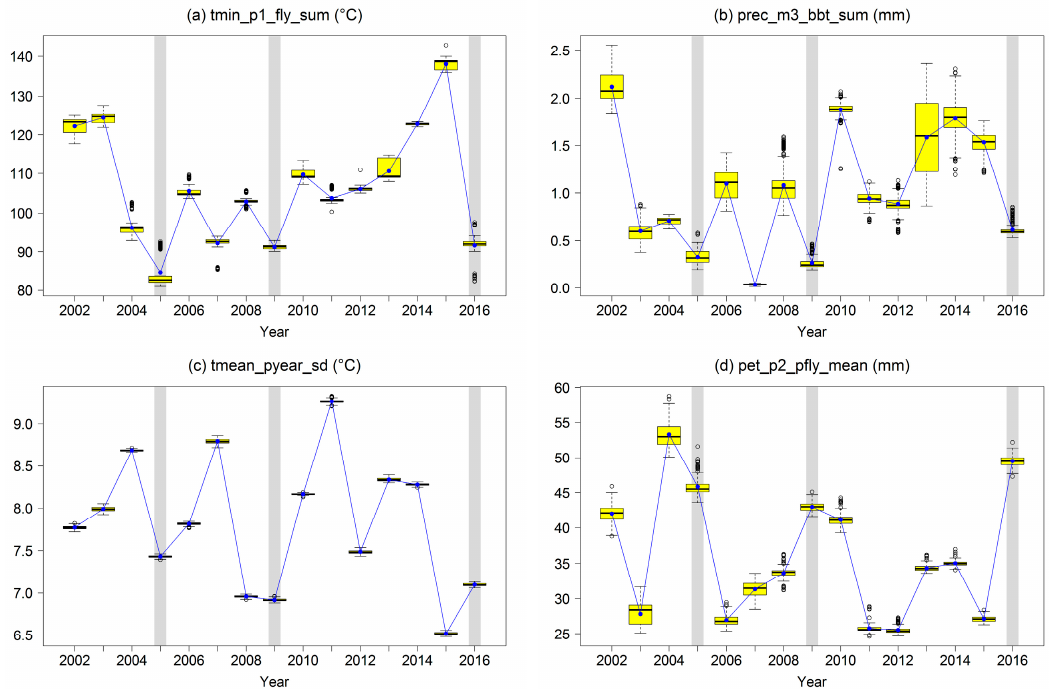
Figure 9. Boxplots of the top four trigger variables by years. The error bars indicate the variability